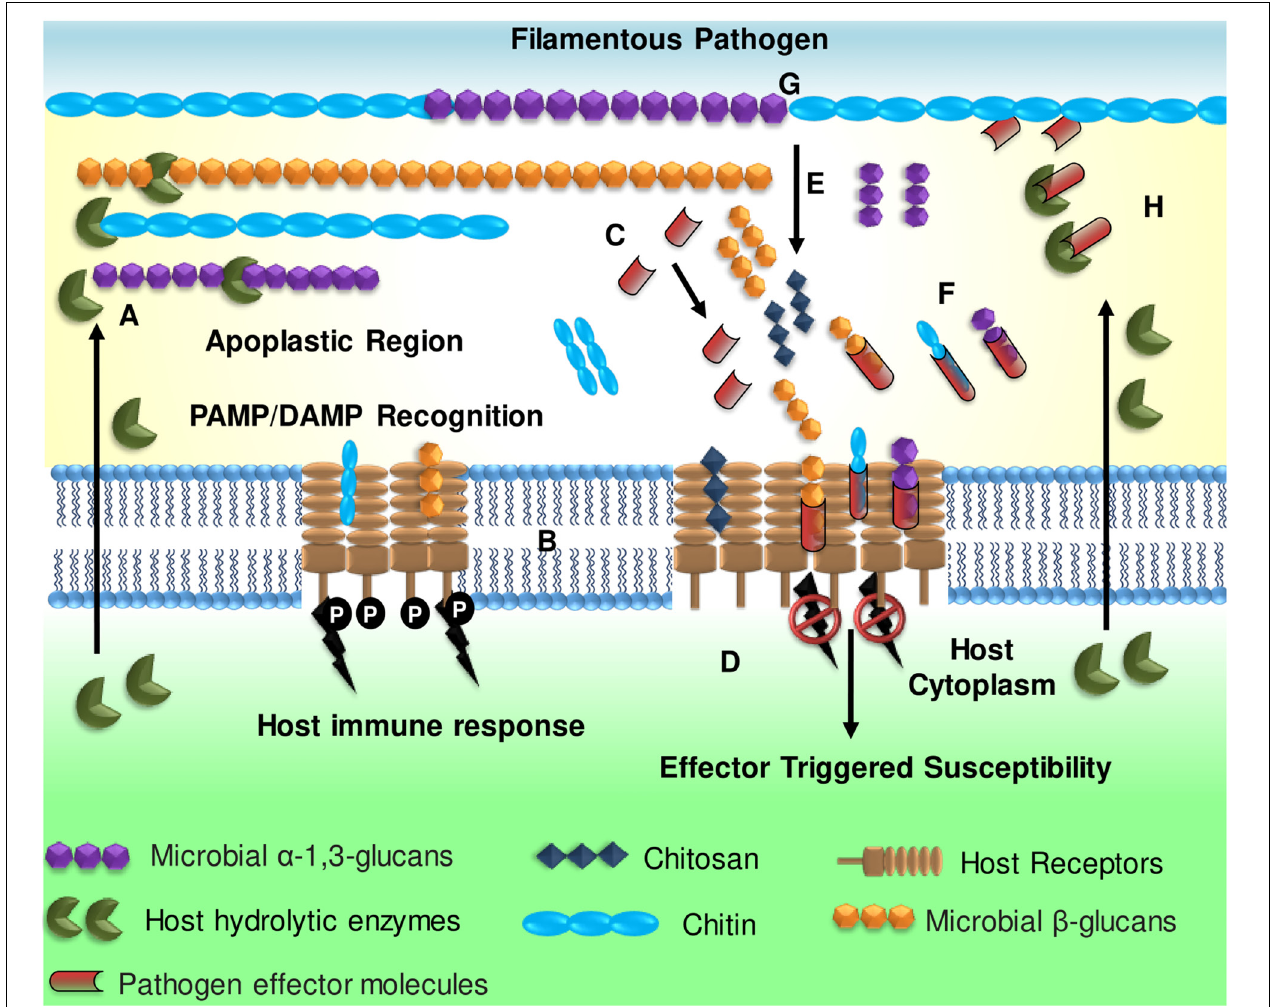
FIGURE 1 | Overview of glycan-triggered immune responses during plant–filamentous pathogen interactions. (A) Filamentous pathogen cell walls are targeted by host-derived hydrolytic enzymes, as an innate defense response resulting in the release of glycan fragments (chitin, α - and β -glucans). (B) The hydrolyzed glycans are recognized as PAMPs by host pattern recognition receptors (PRRs) triggering innate immune response. (C) The pathogen secretes effector molecules that (D) suppress PTI defense responses by (E) converting immunogenic chitin to the less immunogenic chitosan (F) sequestering or masking the PAMPs released, to evade detection. (G) Remodeling of the cell wall components by the pathogen (e.g., accumulation of α -1,3-glucan) mitigates the effect of host-hydrolytic enzymes on the microbial cell wall glycans, thereby preventing hydrolysis. (H) Lastly, the pathogens may secrete certain effectors that directly inhibit host hydrolytic enzymes. (Adapted from Rovenich et al., 2016 and reproduced with permission from John Wiley and